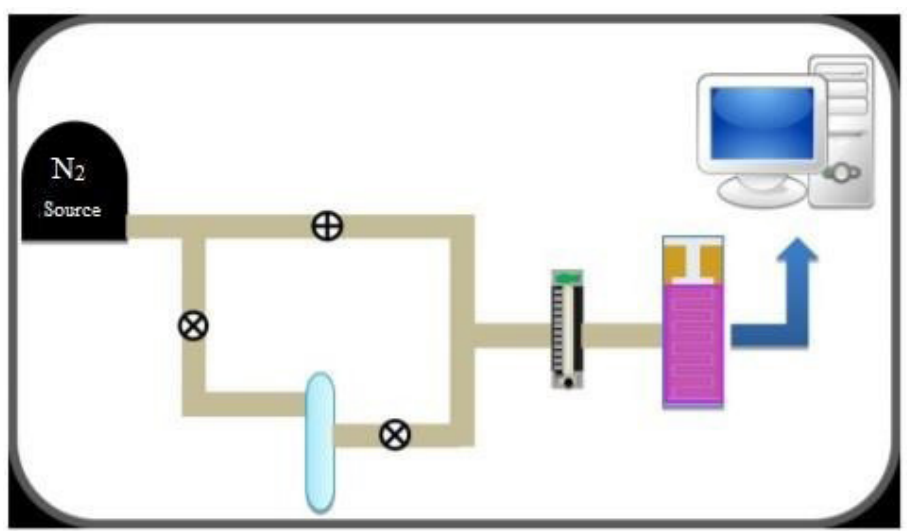
Figure 3. Representation of a golden interdigitate electrode with N = 10 17 .